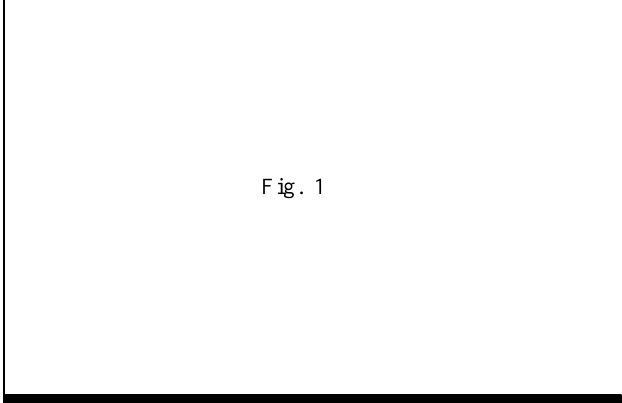
Fig. 1: Microphotograph of oncocytoma of nasal cavity (H&EX20).